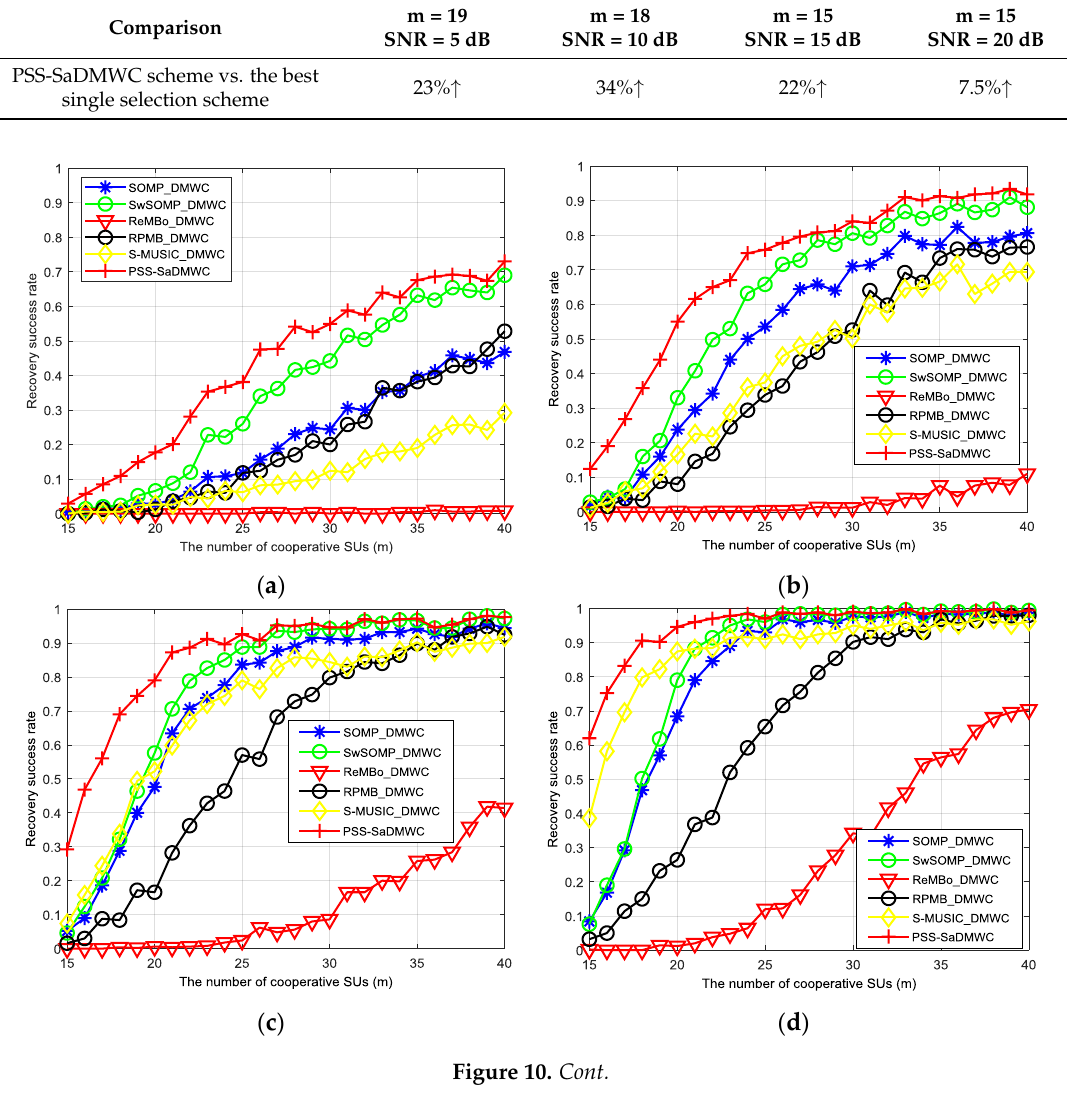
Table 4. Comparison of the maximum promoting rates.